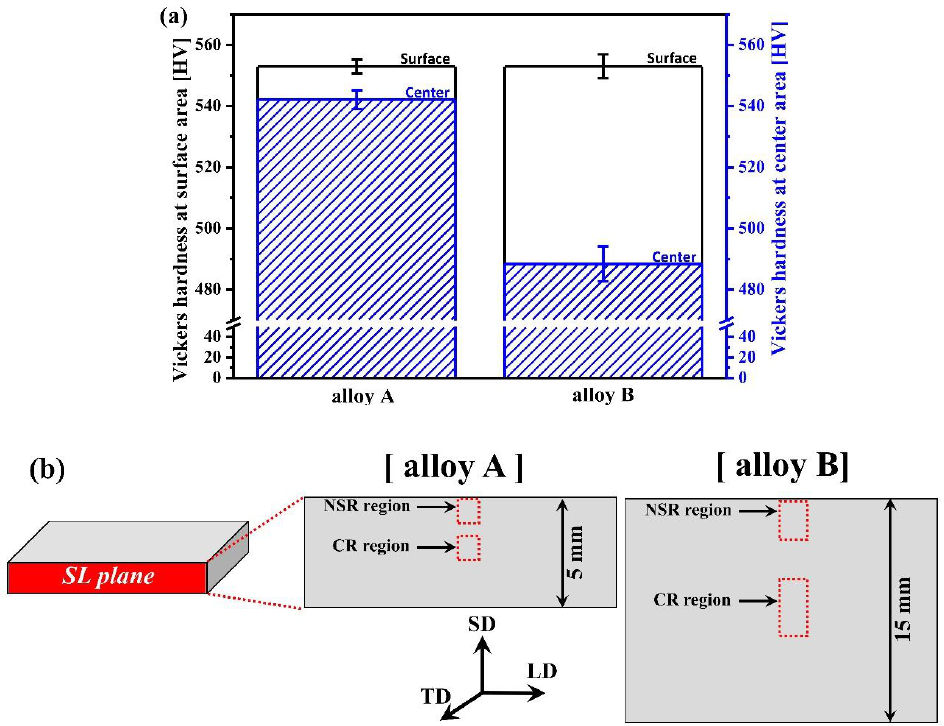
Figure 9. ( a ) Comparison of Vickers hardness of near surface & center region of direct-quenched steels (alloys A and B); ( b ) Vickers hardness measured area of alloys A and B.